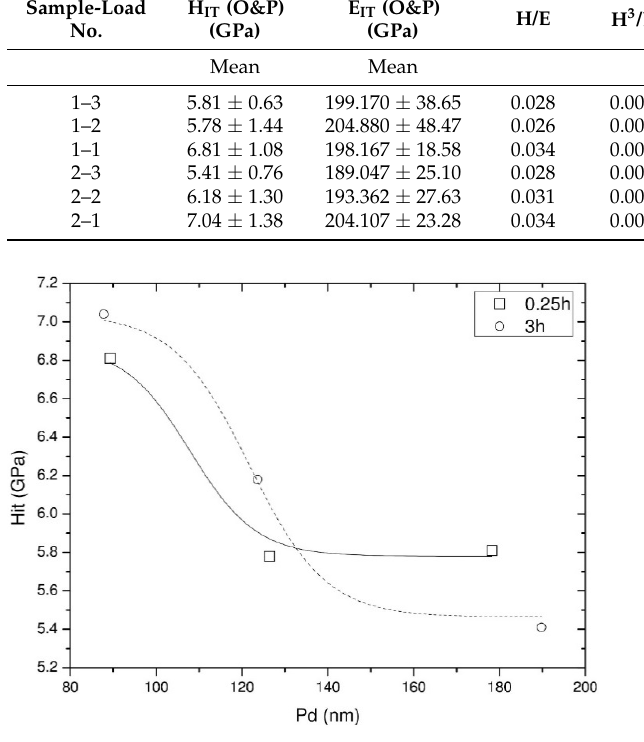
Figure 5. The variation in hardness as function of penetration depth.